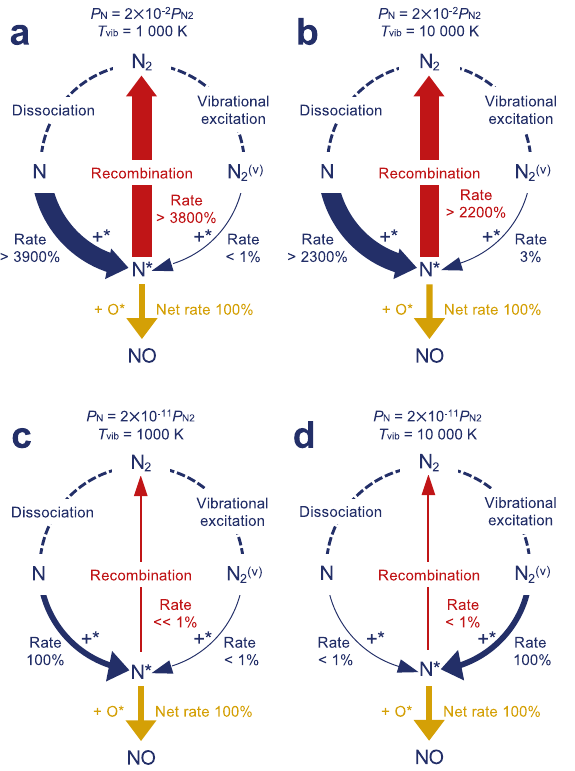
Fig. 5 Reaction fl uxes vs plasma conditions. Steady-state reaction fl ux of N 2 oxidation on Pt(211) in a integral reactor at 873K with ( a ) P N ¼ ¼ 2 ´ 10 (cid:3) 2 P 2 ´ 10 (cid:3) 2 P and T vib = 1000 K, ( b ) P and T vib = 10000K, ( c ) N 2 N N 2 P ¼ 2 ´ 10 (cid:3) 11 P T = 1000K, and ( d ) P ¼ 2 ´ 10 (cid:3) 11 P T = vib vib N N 2 and N N 2 and 10000K, presented as Sankey diagrams, in which each segment indicates a reaction and the corresponding segment width qualitatively indicates the value of the rate normalized to the NO production rate. Solid lines represent reactions involving catalytic sites and dotted lines represent plasma processes. Blue, gold and red mean intermediate, productive and unproductive routes, respectively. The reaction conditions are consistent with the four corners of Fig. 4d.